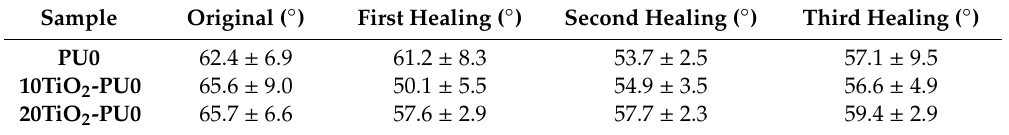
Table 3. Contact angle of the original PU0 and TiO 2 -PU0 nanocomposite films and of the healed films.